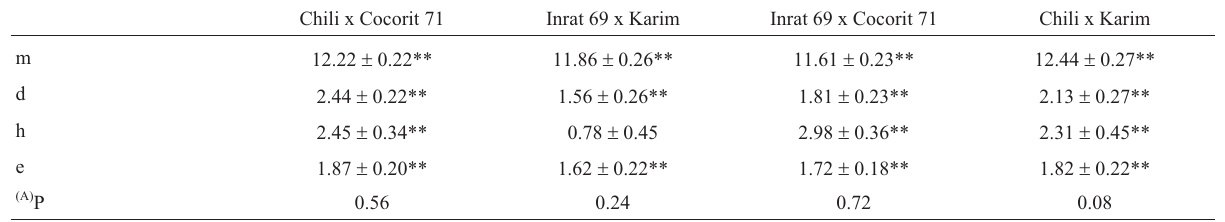
Table 3 - Estimates of the genetic, environmental and genotype x environment interaction components ( (cid:2) SE) of generation means.